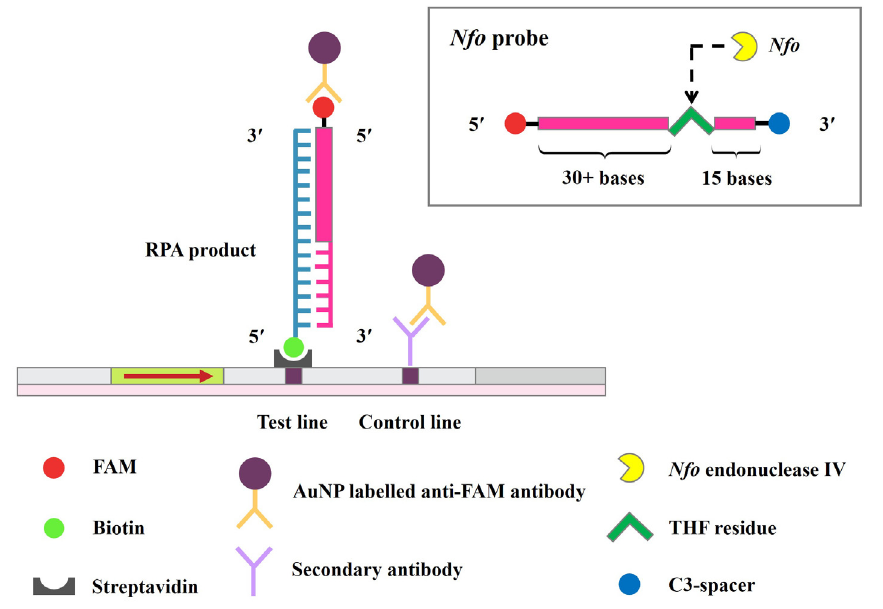
Figure 4. Schematic diagram of the RPA-LF assay: (i) the forward and reverse primers generate the biotin-labelled RPA products; (ii) the internal probe binds to the complementary DNA; (iii) Nfo endonuclease IV cleaves at a basic tetrahydrofuran (THF) site on the probe, thus, creating an extend- able 3 ′ -OH group for polymerization; (iv) the biotin- and FAM (carboxyfluorescein)-labelled RPA products are then detected by lateral flow strip based on sandwich-type reactions; (v) biotin binds to streptavidin on the test line, whereas FAM binds to the gold nanoparticle (AuNP) conjugated anti-FAM antibody; (vi) excess AuNP conjugated anti-FAM antibody is captured by the secondary antibody coated on the control line; and (vii) two visual bands of control and test lines indicate a positive result, whereas a visual band at control line only indicates a negative result.